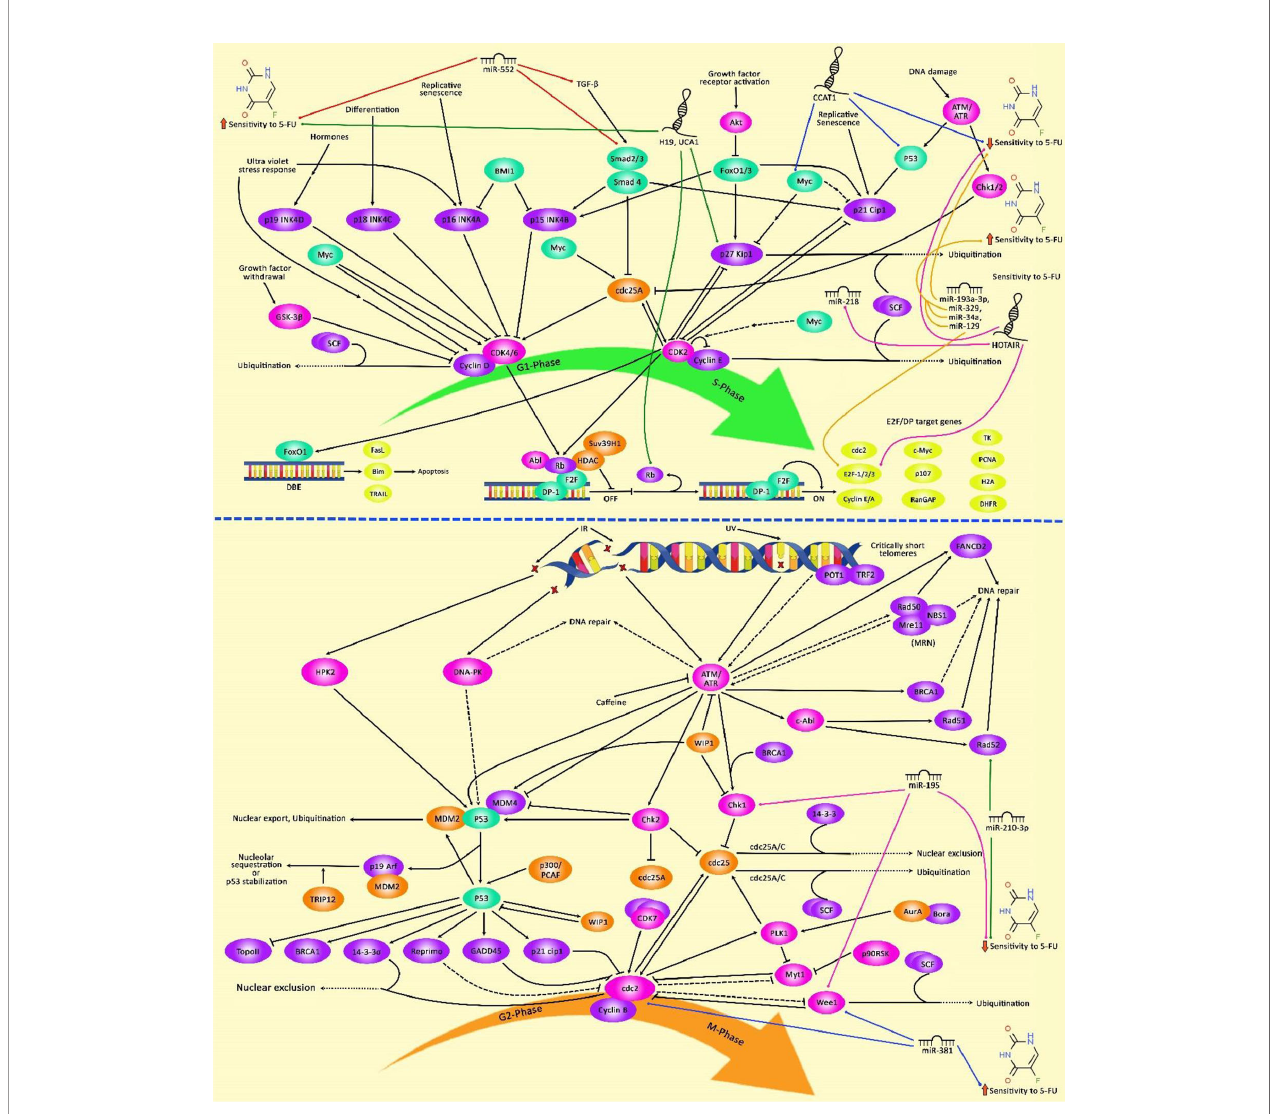
FIGURE 2 | The schematic diagram of the effects of 5-FU on G1 and G2 phase cell cycle arrest in tumor cells through regulation by various non-coding RNAs. 5- fl uorouracil has been highly applied for chemotherapy of gastrointestinal cancers and is known to affect the cell cycle and trigger apoptotic death of cancer cells. Non-coding RNAs have an important role in regulating cell cycle mechanisms via modulating the effects of 5-FU on the expression of G1/S and G2/M-related cell cycle regulators in tumor cells. LncRNA HOTAIR via downregulating the expression level of miR-218 and promoting the activation of NF- k B/TS signaling cascade could induce upregulation of the cell cycle transcription factor E2F-1, and thereby contributing to 5-FU Resistance and elevating enhanced colorectal cancer cell carcinogenesis (124). Besides, miR-381 via downregulation of the expression level of WEE1 and upregulation of the activity of Cdc2 results in alteration in cell cycle regulation which could potentiate the anti-tumor ef fi cacies of 5-FU and abrogate G2/M cell cycle arrest in renal cancer cells (118). Additionally, miR-195 via directly targeting checkpoint kinase 1 (CHK1) and G2 checkpoint kinase WEE1 could desensitize colorectal cancer cells to 5-FU. This result demonstrates that miR-195 has a potential role in promoting the cell cycle via elevating G2/M transition after exposure to 5-FU